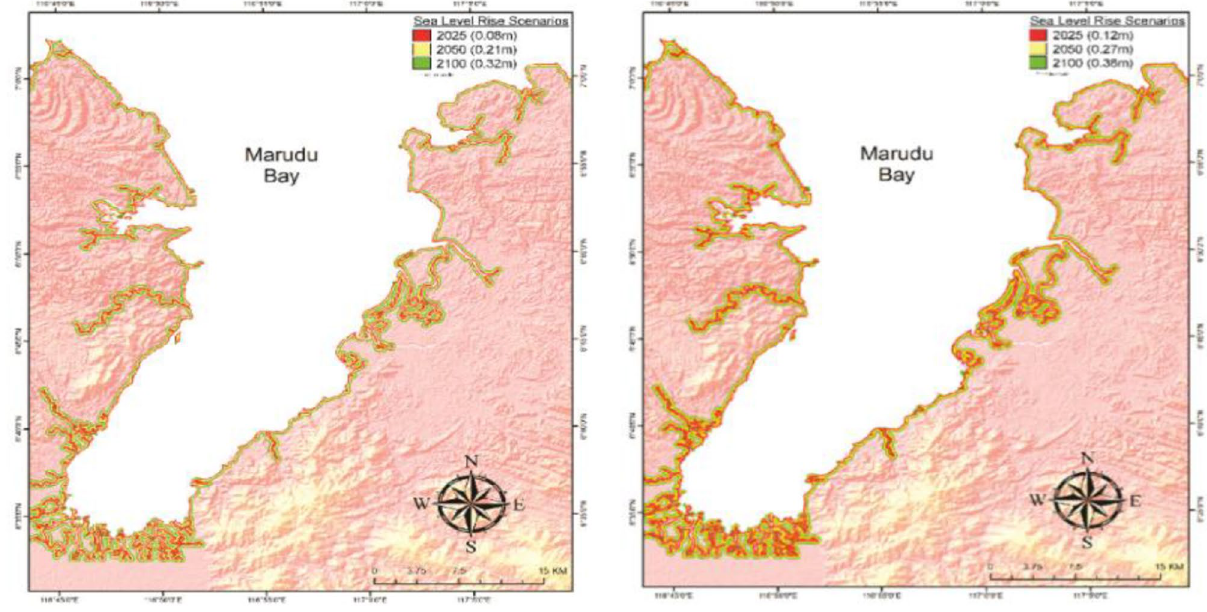
Fig. 7 Projected sea-level rise under (a) RCP 4.5 and (b) RCP 8.5 climate scenarios during the winter monsoon (January) and summer mon- soon